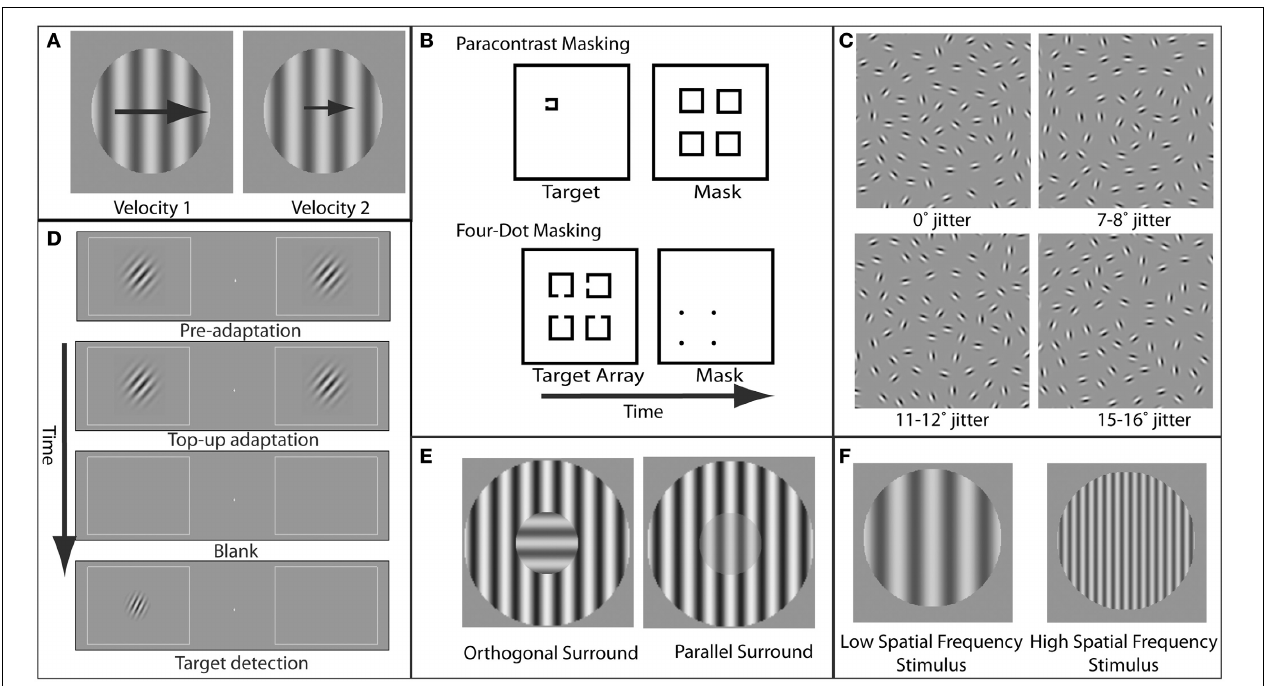
FIGURE 1 | Examples of paradigms and stimuli used to study specific visual deficits in schizophrenia. (A) Velocity perception. In velocity discrimination tasks, subjects compare the velocity (represented here by the size of the arrows) of two sequentially presented stimuli (in this case, gratings). (B) Masking. In paracontrast masking, the mask interrupts formation of the stimulus percept. Because the mask does not spatially overlap the target contours, paracontrast masking cannot occur through integration of the target and mask. In four-dot masking, the mask is thought to disrupt reentrant processing but not formation of object representations. (C) Perceptual grouping. A set of elements in the display is perceptually grouped via contour integration to form a coherent percept (in this case, an ellipse). As the amount of orientation jitter between the different elements